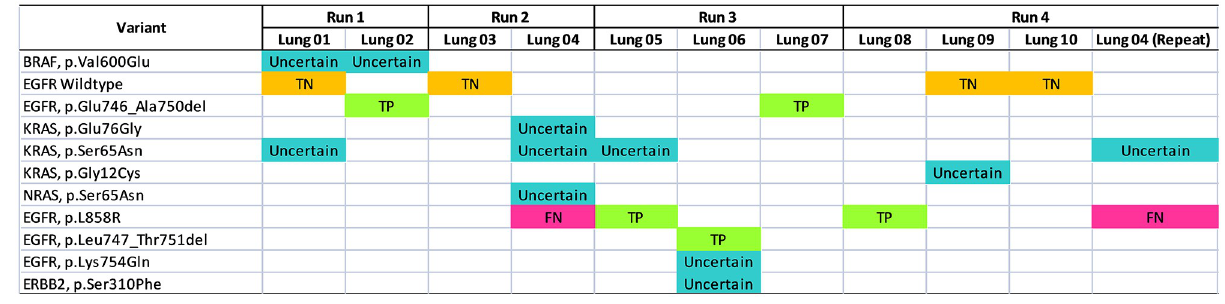
Fig 3. Clinical validation of the 10 patients with newly diagnosed advanced stage III or stage IV lung cancer. Variants are listed vertically and samples are shown horizontally. Known EGFR true positive (TP), true negative (TN) and false negative (FN) are shown in green, orange and red respectively. Comparison with tissue EGFR demonstrated that the 15-gene ctDNA panel achieved 83.3% clinical sensitivity and 100% clinical specificity. In addition to known EGFR mutation status, the NGS assay detected additional variants which are shown in blue, and confirmation with orthogonal method is warranted to confirm its